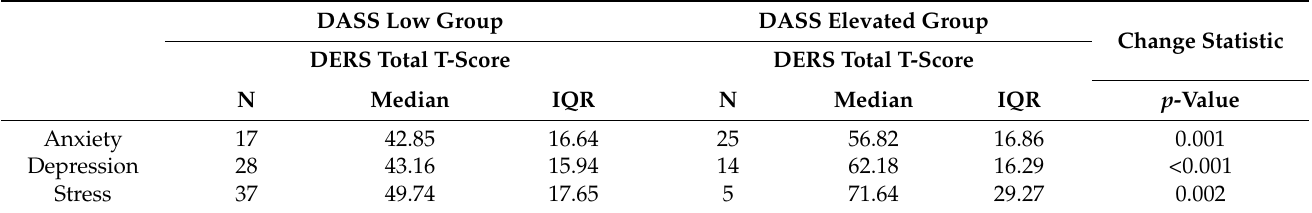
Table 3. Non-parametric relationship between depression, anxiety, and stress and total emotion regulation T-scores. DASS Low